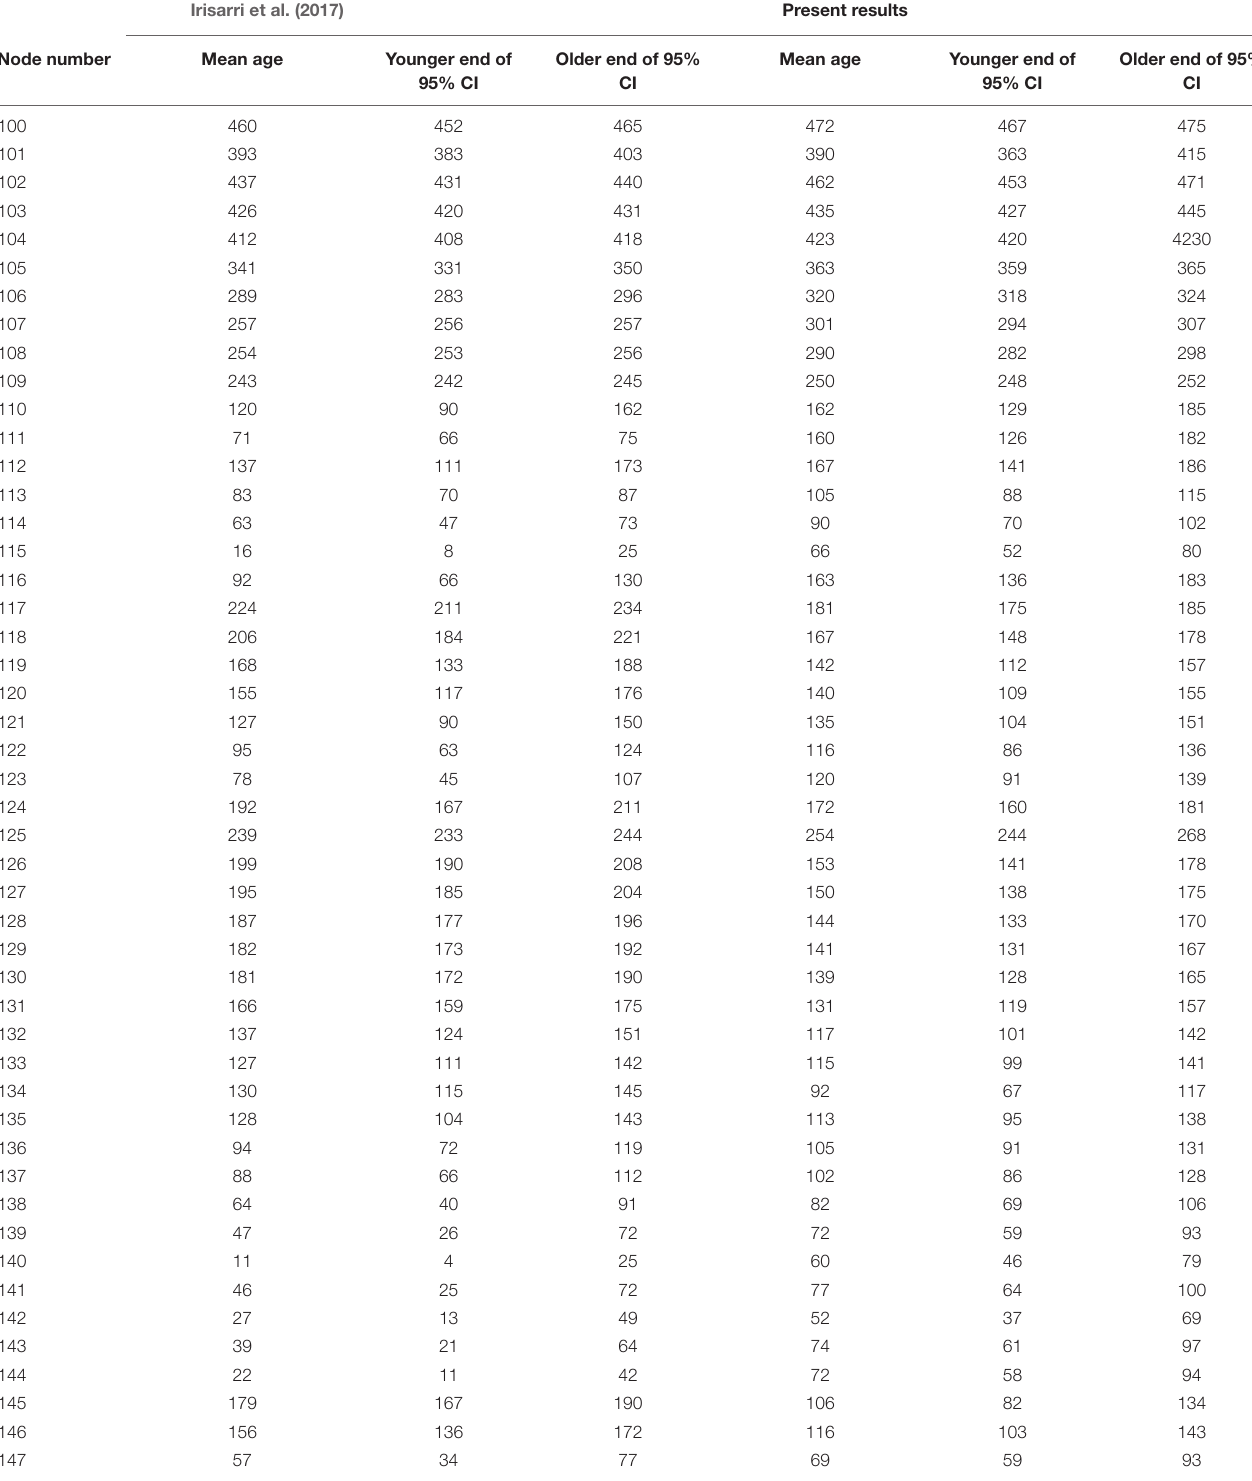
TABLE 2 | The ages found by Irisarri et al. (2017: supplementary table 9: last three columns) when all calibrations were used (all bounds treated as soft, mean ages averaged over 100 gene-jackknifed runs, extremes absolute over all runs), and the results obtained here with the updated calibrations (all bounds treated as hard, mean ages averaged over two runs with the full dataset, extremes absolute over both